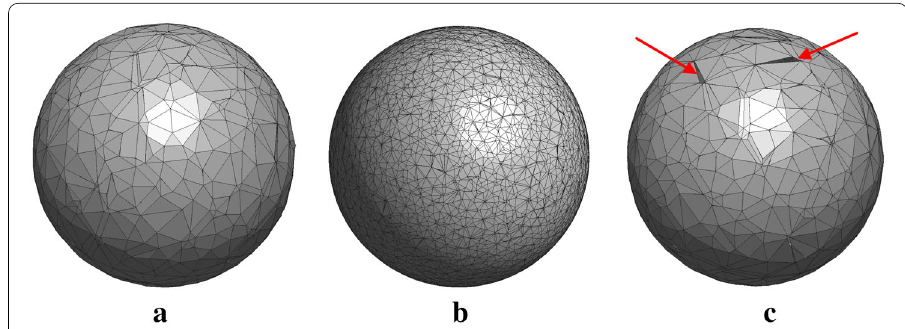
Fig. 15 Surface approximation of a sphere immersed into a background mesh. a Reconstruction of immersed boundary ( (cid:2) A ) given a coarse background mesh. b Reconstruction of (cid:2) A given a fine background mesh. c Reconstruction of (cid:2) A without considering double-intersected edges